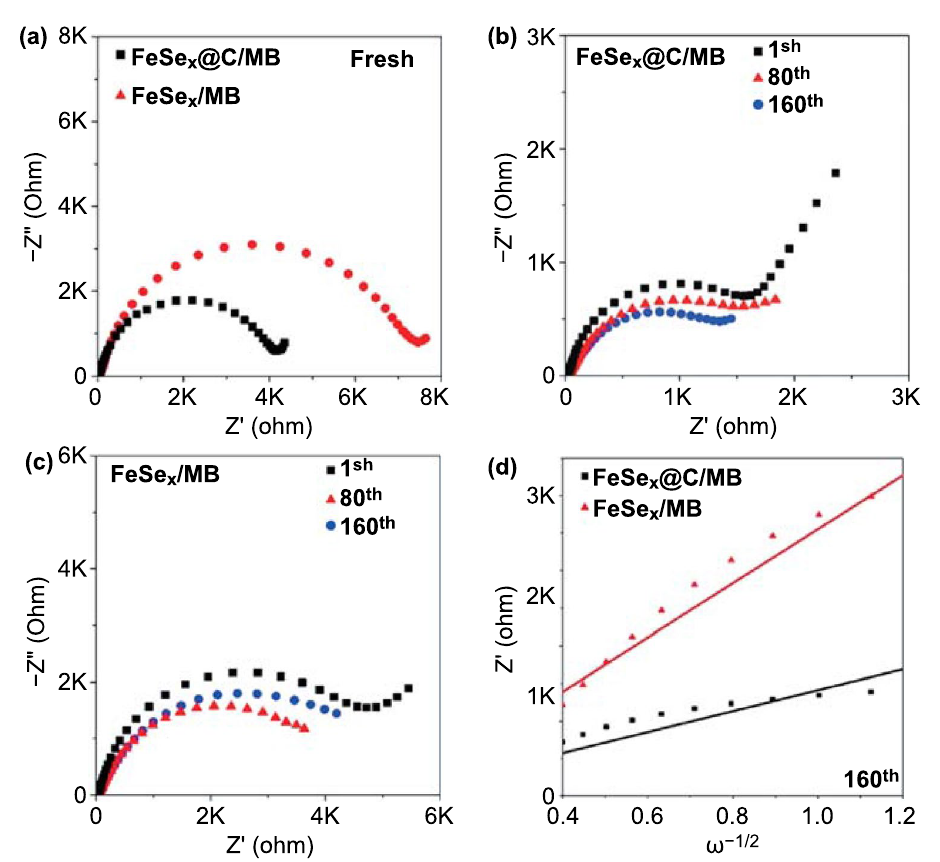
Fig. 10 Nyquist plots of of FeSe x @C/MB and FeSe x /MB: a fresh cells, b, c after the 1st, 80th, and 160th cycle, and d the relationship between the phase angle (ω −1/2 ) and impedance (Z’) at the 160th